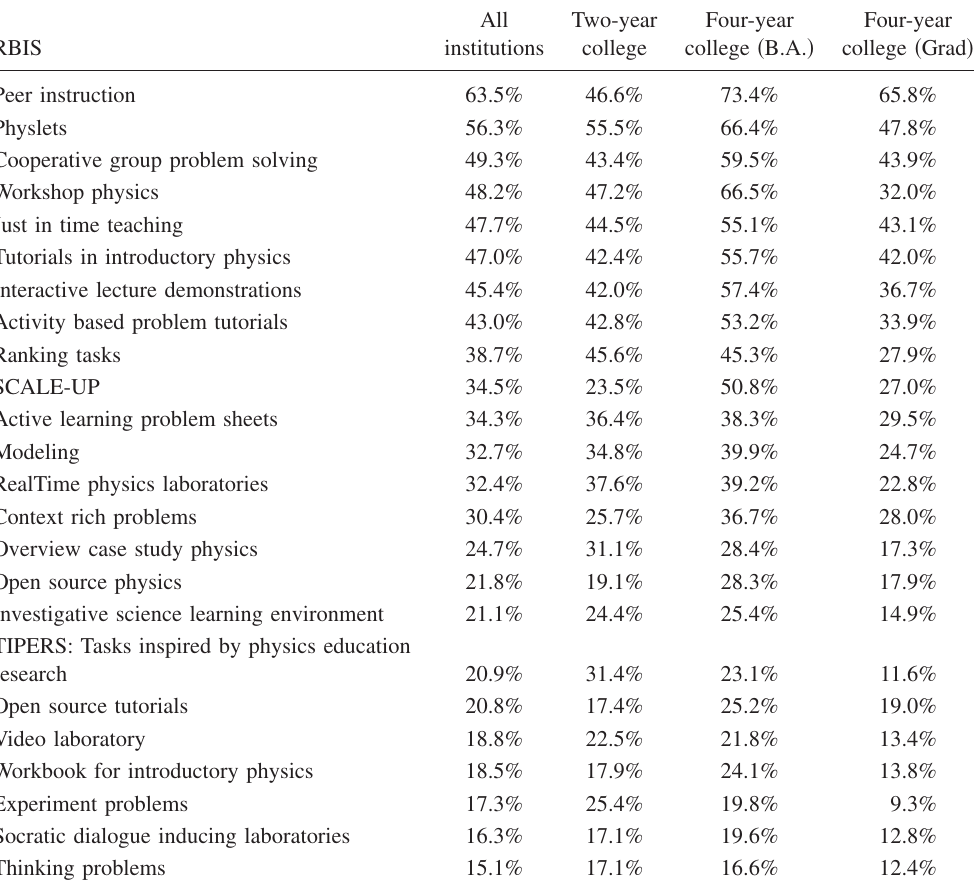
TABLE VI. Ranking of the 24 RBIS according to level of Knowledge (cid:1) percentage of faculty who indicate that they are familiar with or have used the RBIS (cid:2)